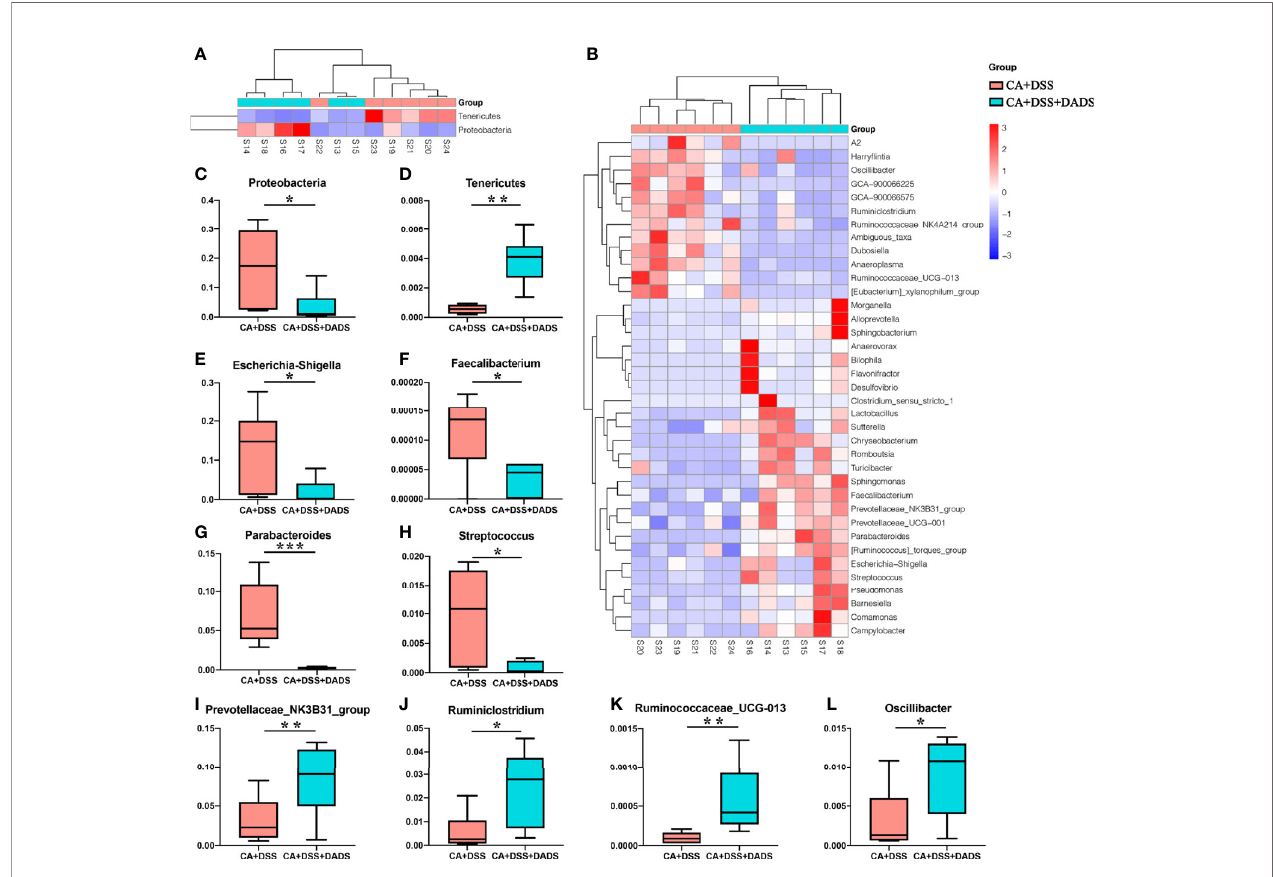
FIGURE 7 | Heatmaps of key bacteria at the (A) phylum and (B) genus levels. The relative abundances of (C) Proteobacteria , (D) Tenericutes , (E) Escherichia – Shigella , (F) Faecalibacterium , (G) Parabacteroides , (H) Streptococcus , (I) Prevotellaceae_NK3B31_group , (J) Ruminiclostridium , (K) Ruminococcaceae_UCG-013 , and (L) Oscillibacter in the two groups.